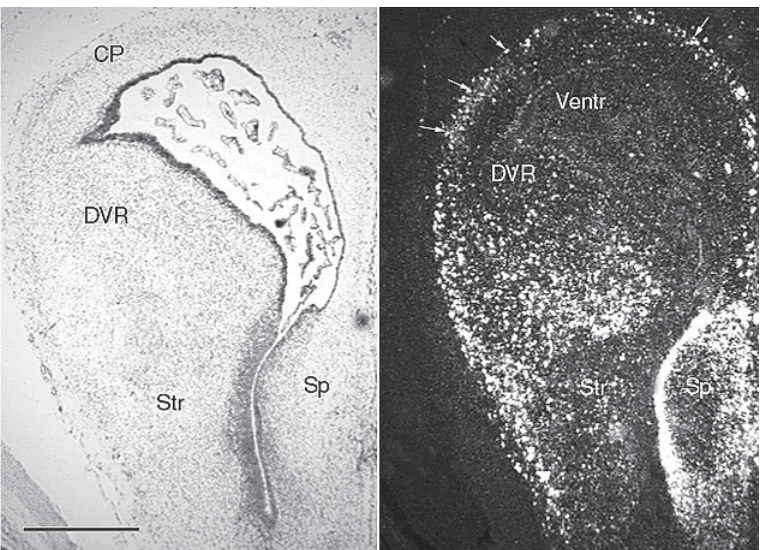
Figure 6. Reelin mRNA expression in the embryonic cortex of crocodiles. Bright and dark field view of a coronal section through a crocodile embryo. In situ hybridization with a [ 33 P]- labeled, species-specific reelin riboprobe. The cortical plate (CP) has an intermediate level of radial organization and is reelin negative, whereas the marginal zone contains reelin- positive neurons (arrows). Ventr: ventricle; Str: striatum; DVR: dorsal ventricular ridge; Sp: septum. Magnification bar: 500 µm.